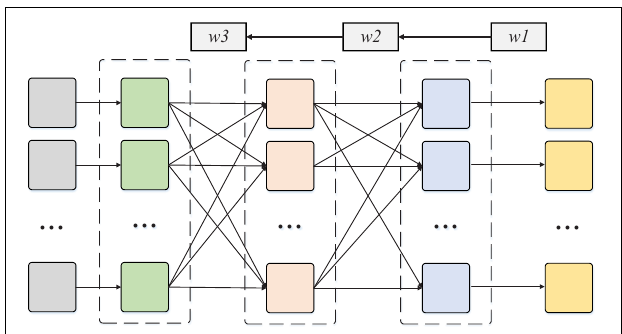
FIGURE 2 | Structure diagram of multilayer reverse neural